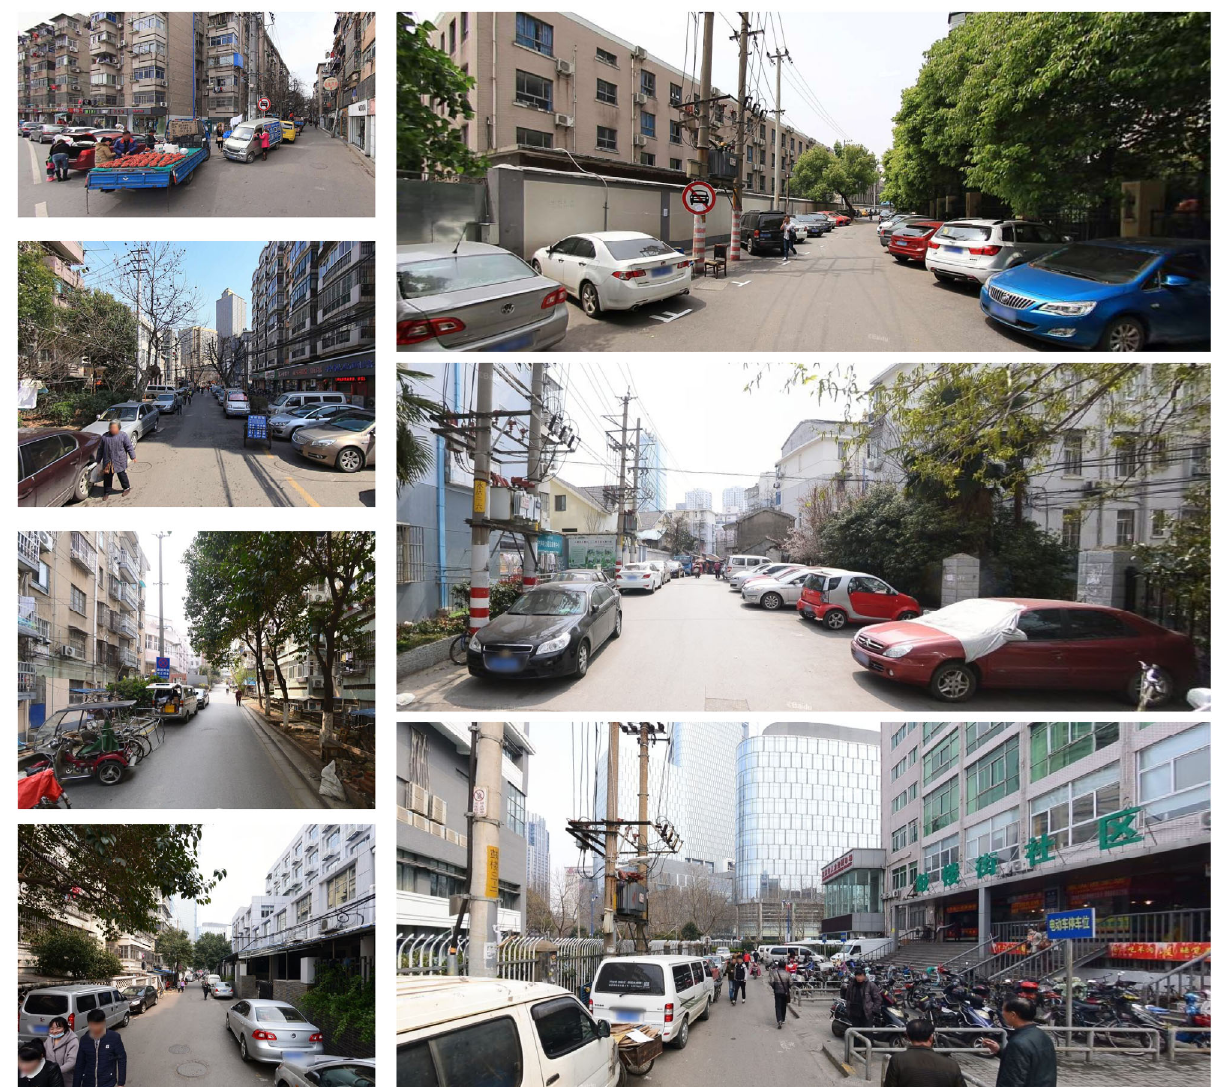
Figure 19. The representative scenes for HS2 are caused by motor vehicle and bicycle parking.